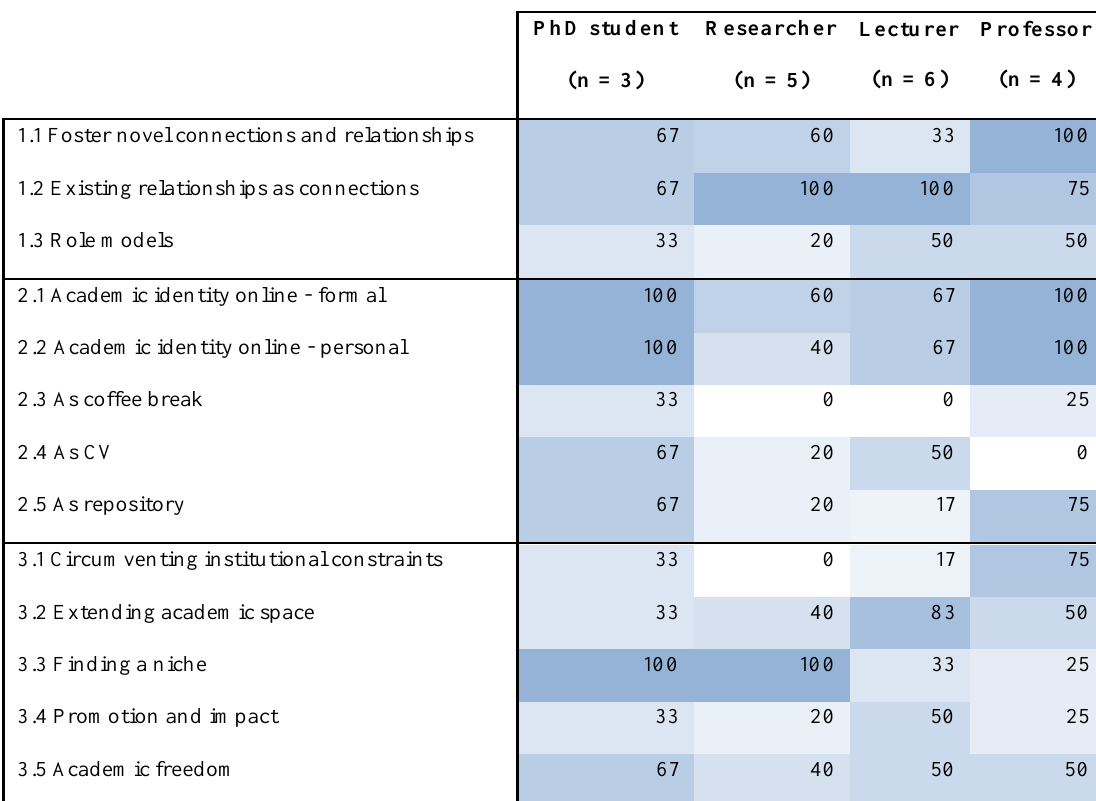
Matrix Coding Query of Themes According to Job Position, Shown as a Percentage of Participants Within Each Job